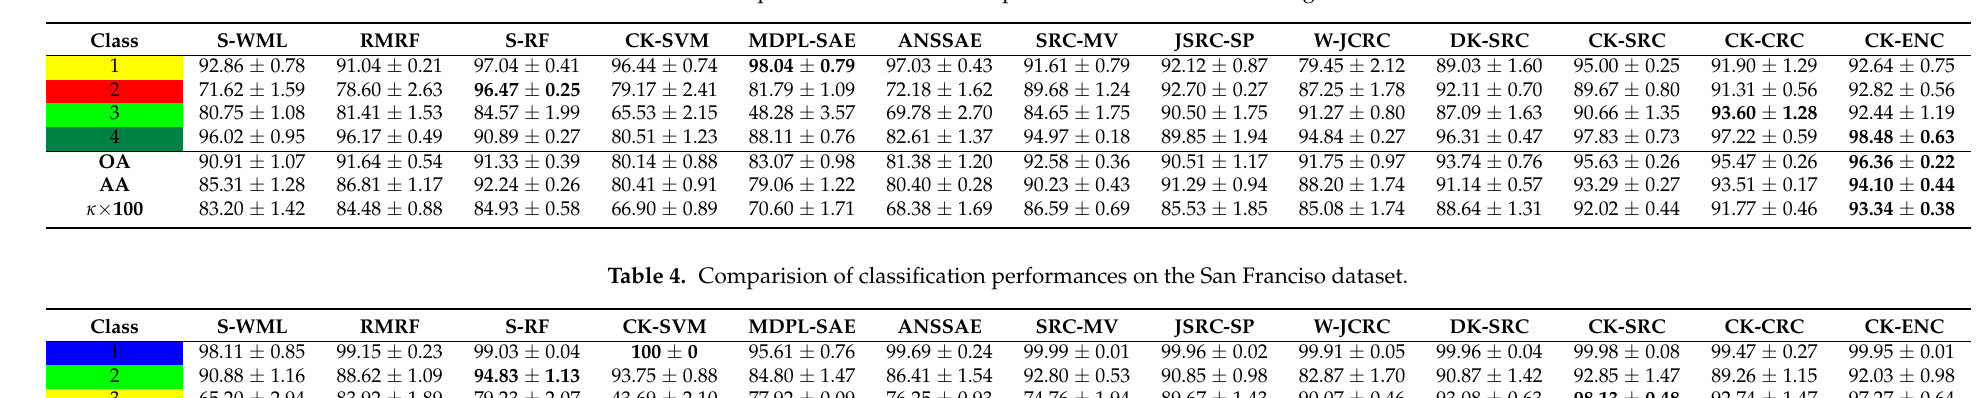
Table 3. Comparision of classification performances on the Yihechang dataset.